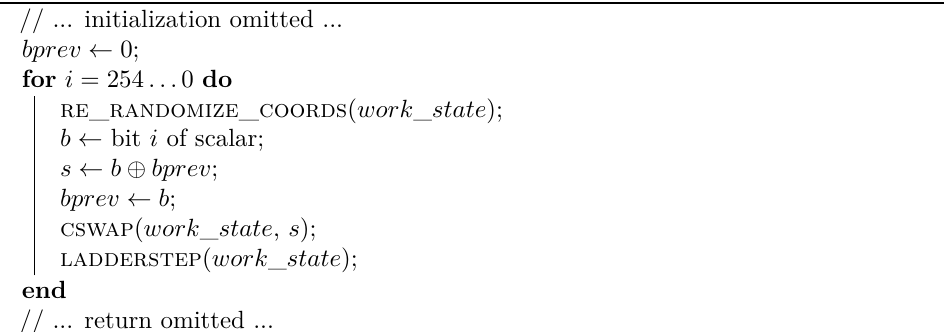
Algorithm 1: Montgomery ladder with cswap and coordinate